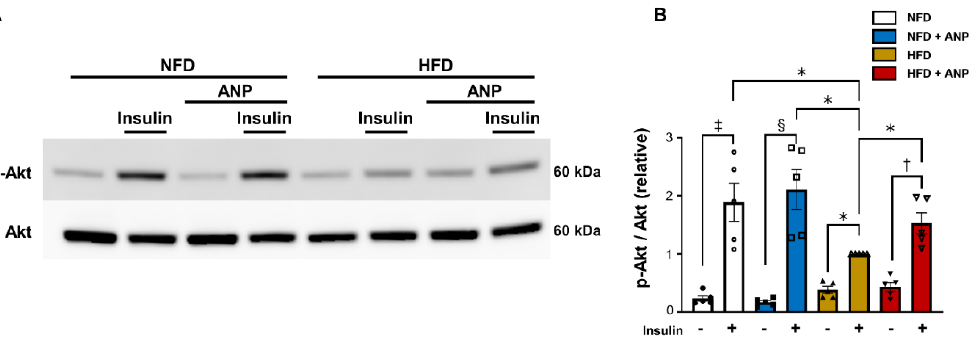
Figure 2. Exogenous ANP treatment ameliorated myocardial insulin resistance. In vivo myocardial insulin sensitivity was assessed by measuring insulin-induced phosphorylation of Akt. ( A ) Repre- sentative immunoblots for phospho- and total Akt from cardiac lysates. ( B ) Densitometric quantita- tion normalized to the level of p-Akt/total Akt expression in HFD with insulin hearts is shown (n = 5 each). * p < 0.05 versus HFD, † p < 0.05 versus HFD+ANP, ‡ p < 0.05 versus NFD, § p < 0.05 versus NFD+ANP.